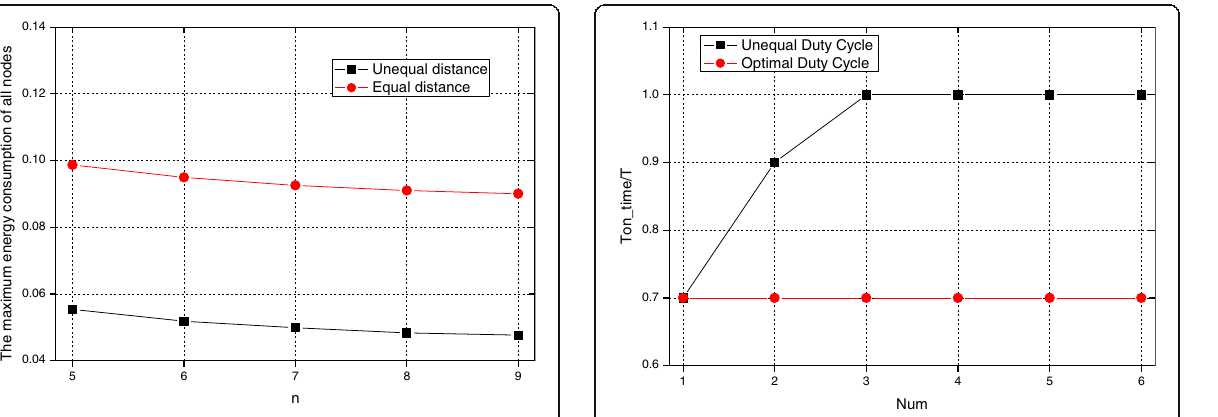
Fig. 13 The duty cycle used at each node in linear network (MQAM)